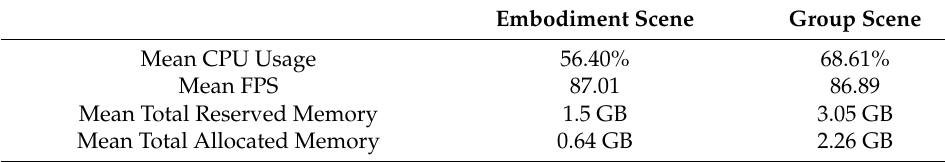
Table A8. Mean results for Test Condition